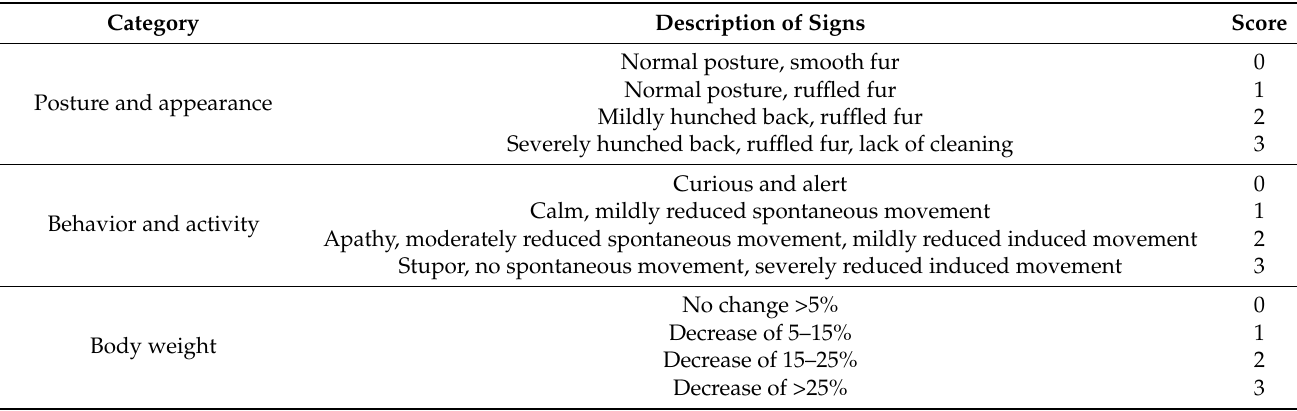
Table 2. Clinical score